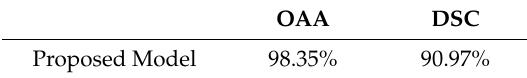
Table 2. The results of the evaluation